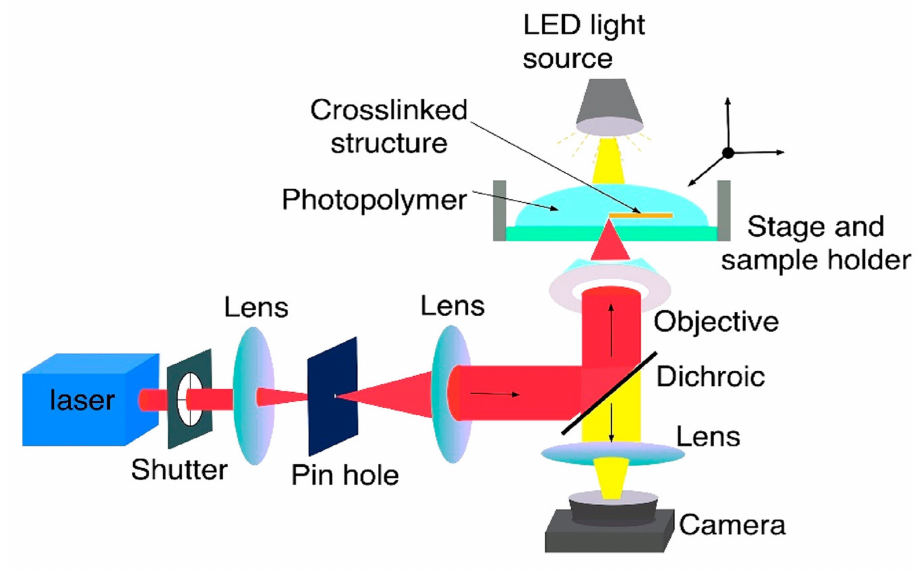
Figure 23. Setup of the direct laser writing system. Reprinted with permission from Ref.